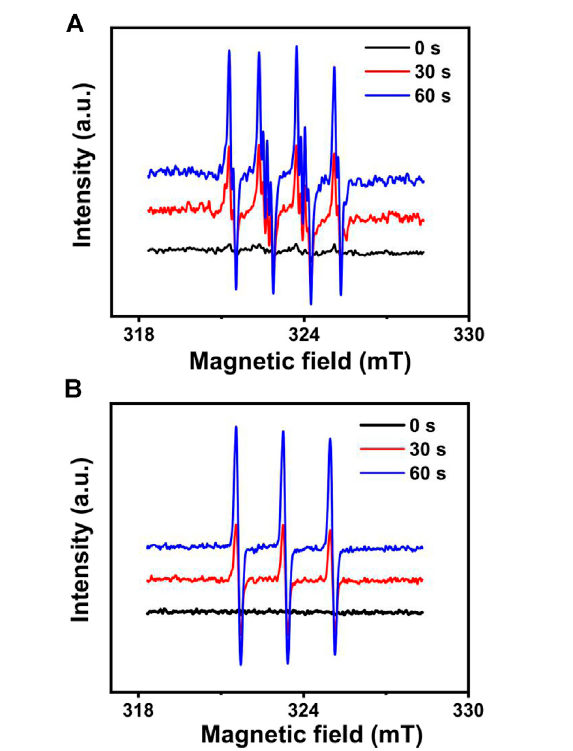
FIGURE 5 | (A) EPR signals of DMPO (for Type I ROS detection) in the presence of C 60 @SAC4A (80 μ M for C 60 ) with NADH (5 mM) irradiated for 0, 30, or 60 s. (B) EPR signals of TEMP (for Type II ROS detection) in the presence of C 60 @SAC4A (80 μ M for C 60 ) irradiated for 0, 30, or 60